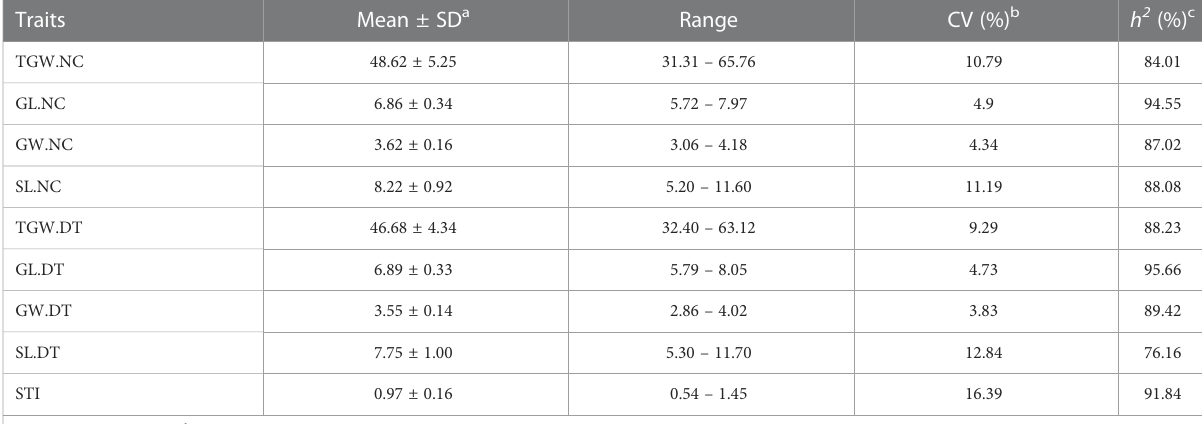
TABLE 1 Statistics for thousand-grain weight (TGW), grain length (GL), grain width (GW), spike length (SL) and stress tolerance index (STI) in the association population under normal (NC) and drought treatment (DT) conditions. Traits Mean ± SD a Range CV (%) b h 2 (%) c